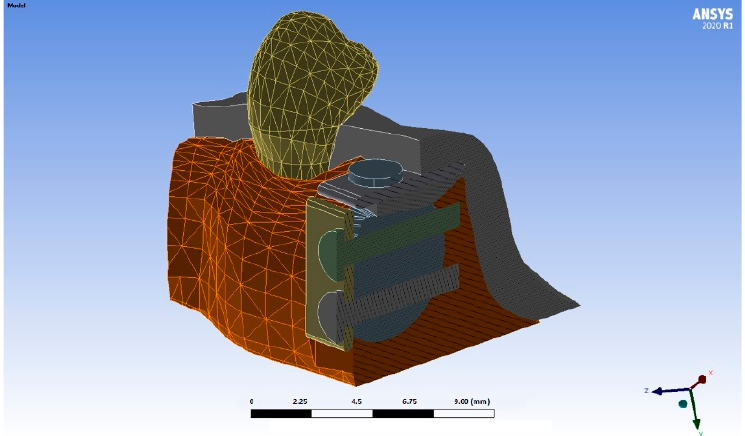
Figure 1. Simulation of a thin bone block with rounded edges (different colors are used to distinguish different parts of the model) .